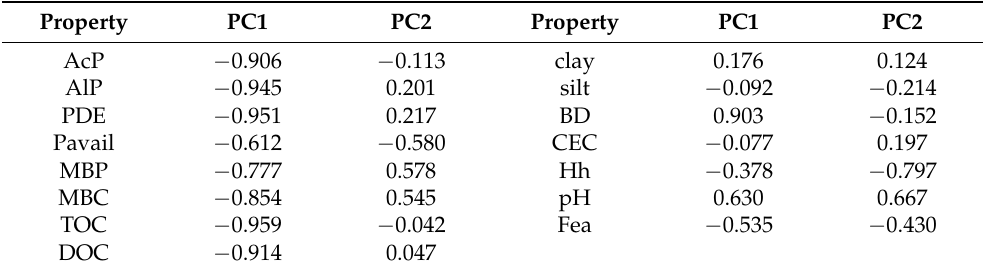
Table 6. Loading scores of the properties for the principal component analysis.